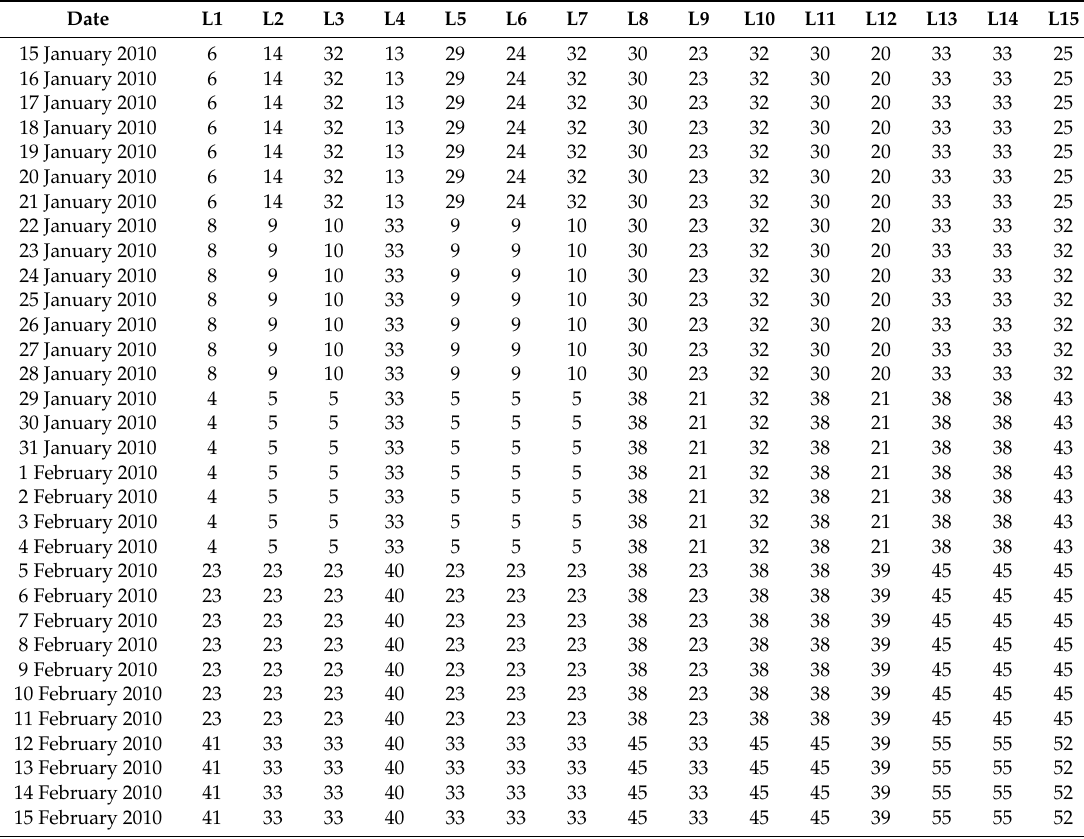
Table A3. H eq _ avg (cm) determined by date and leg